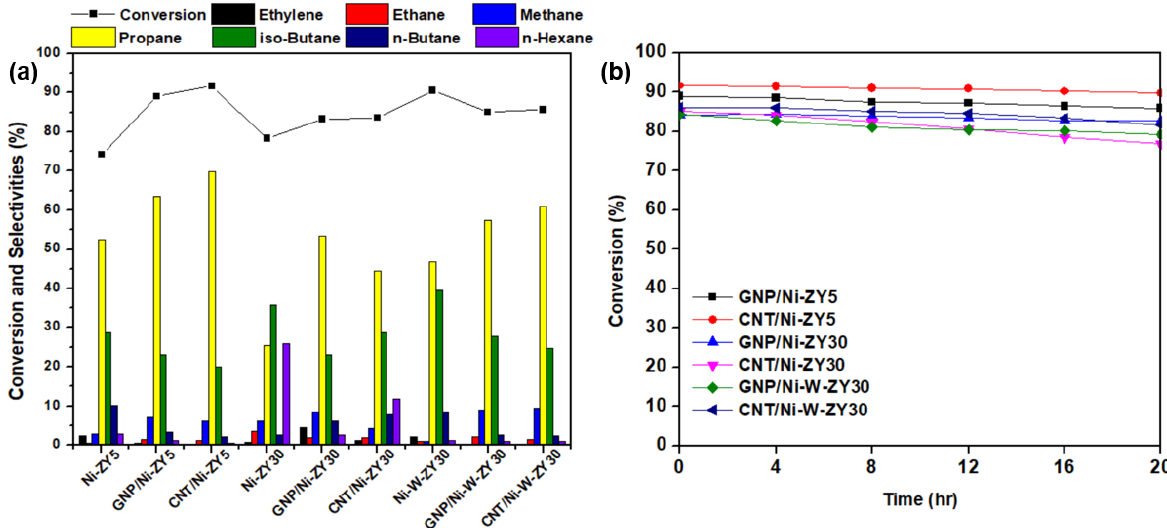
Figure 8. ( a ) Conversion and selectivity percentages of the main products for the prepared catalysts and the reference catalysts, and ( b ) heptane conversion over 20 h